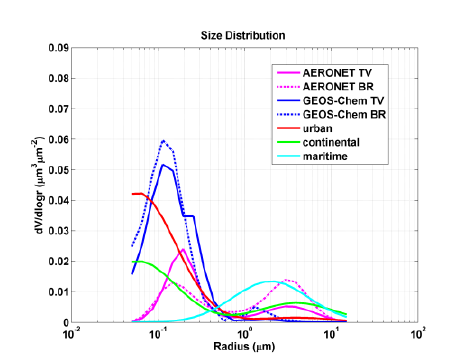
Figure 2. Real (top) and imaginary (bottom) part of the refractive index obtained from urban (red), continental (green) and maritime (cyan) 6SV aerosol standard types, AERONET data (magenta) and GEOS-Chem model (blue) corresponding to CHRIS image of 1 st May 2005 (dashed-line) over Tor Vergata (TV) and of 19 th August 2009 (solid line) over Bruxelles (BR).